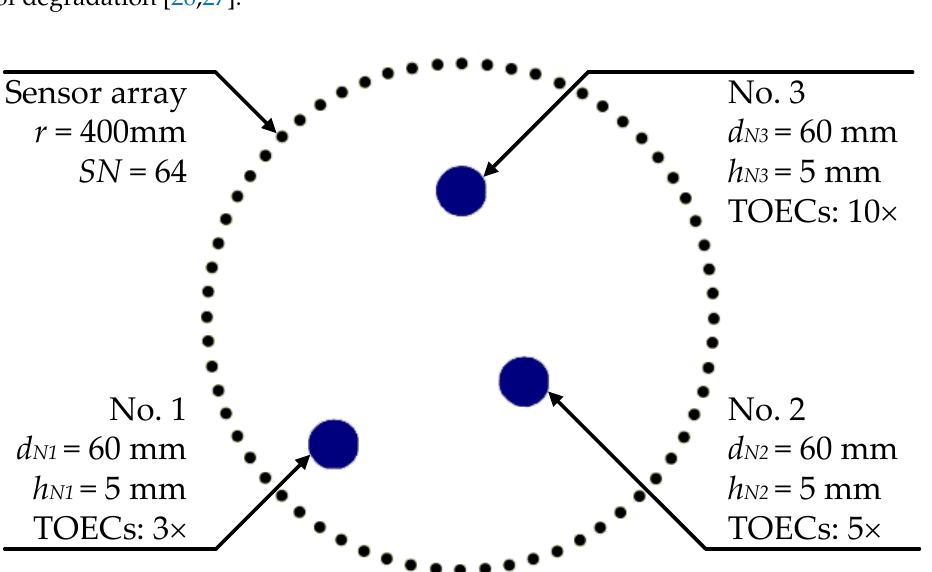
Figure 4. Aluminum plate model with early-life material degradations of different degrees. The other model is defined without these three degradations.